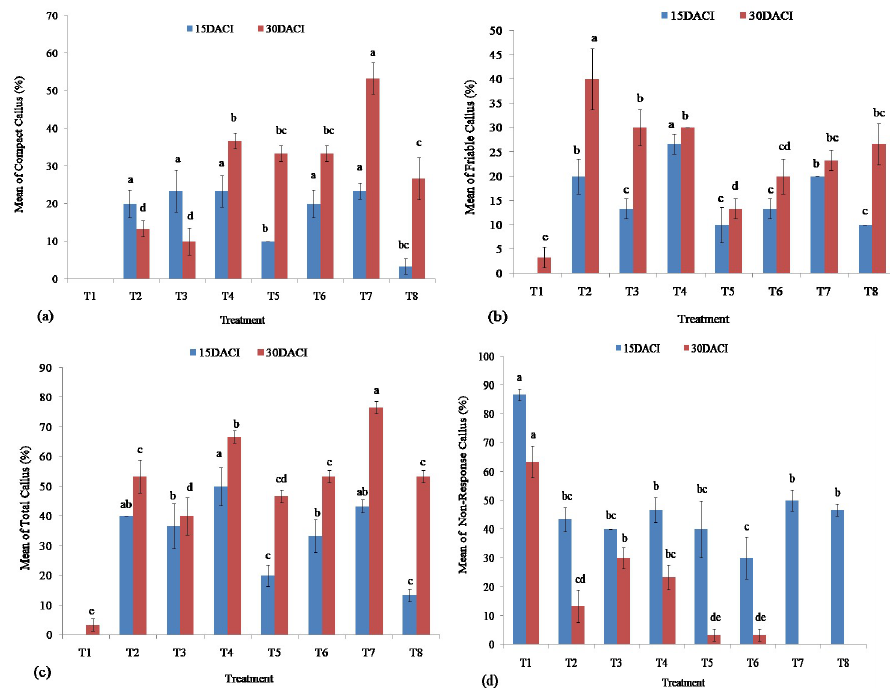
Figure 3. Frequencies of callus induction during in vitro culture of stevia on MS media supplemented with different concentrations of 2,4-D and zeatin: ( a ) compact callus; ( b ) friable callus; ( c ) total callus; and ( d ) non-response of stevia explants. Bars denote the mean of three replications per treatment ± SE (standard error). Mean values with the same letters are not significantly different based on the Student’s t -test at p = 0.05. The MS media with different concentrations of 2,4-D and zeatin showed different levels of efficiencies in forming friable callus from cultured leaf segments of stevia at 15 and 30 DACI. The significantly highest (26.67%) percentage of friable calluses wasin- duced on the MS media supplemented with 0.50 mg/L 2,4-D and 0.10 mg/L zeatin at 15 DACI, whereas at 30 DACI, the MS media with 0.10 mg/L 2,4-D and zeatin showed 40% induction of friable callus. The lowest frequencies (0.00 and 3.33%) of friable callus in- duction were found using MS media without any plant growth hormones at 15 DACI and 30 DACI, respectively (Figure 3b). At 15 DACI, the MS media with 0.10 mg/L zeatin and different concentrations of 2,4-D (0.10 mg/L, 0.25 mg/L, 0.75 mg/L, 1.00 mg/L, 1.50 mg/L, and 2.00 mg/L) produced 20, 13.33, 10, 13.33, 20, and 10% of friable callus whereas at 30 DACI, the MS media supplemented with 0.10 mg/L zeatin along with 0.25 mg/L, 0.50 mg/L, 0.75 mg/L, 1.00 mg/L, 1.50 mg/L, and 2.00 mg/L of 2,4-D induced 30, 30, 13.33, 20, 23.33 and 26.67% of friable callus, respectively. The MS media utilized for the induction of calli showed different efficiencies in in- ducing calli from the explants of stevia at both 15 and 30 DACI. The highest (50%) per- centage of callus formation was achieved from the explants cultured on the MS media